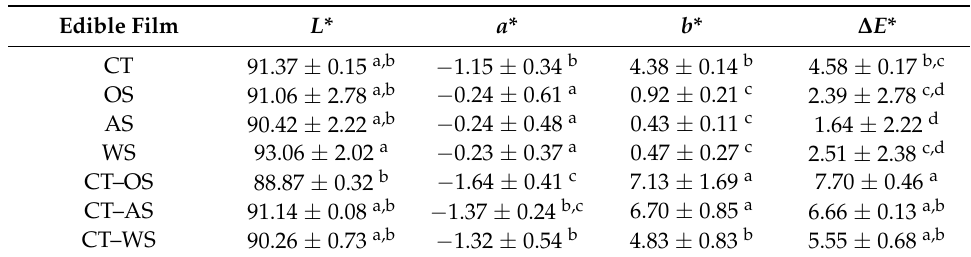
Table 1. Color parameters of edible films made from CH-only, starches-only and mixtures CH-starches (1:3 w / w ) ratio,